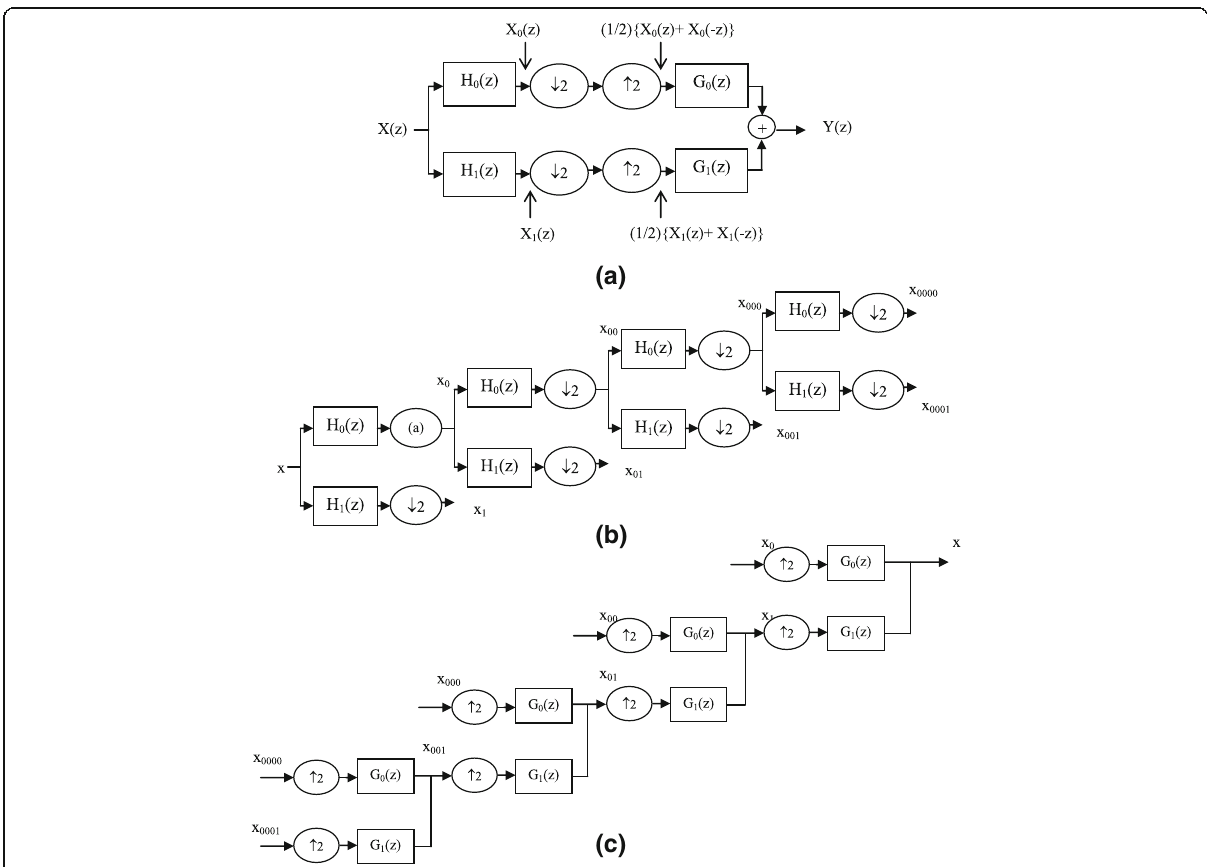
Fig. 5 Reconstruction and decomposition based on wavelet. a Full decomposition-reconstruction of two band filter bank. b Decomposition tree of wavelet packet. c Reconstruction tree of wavelet